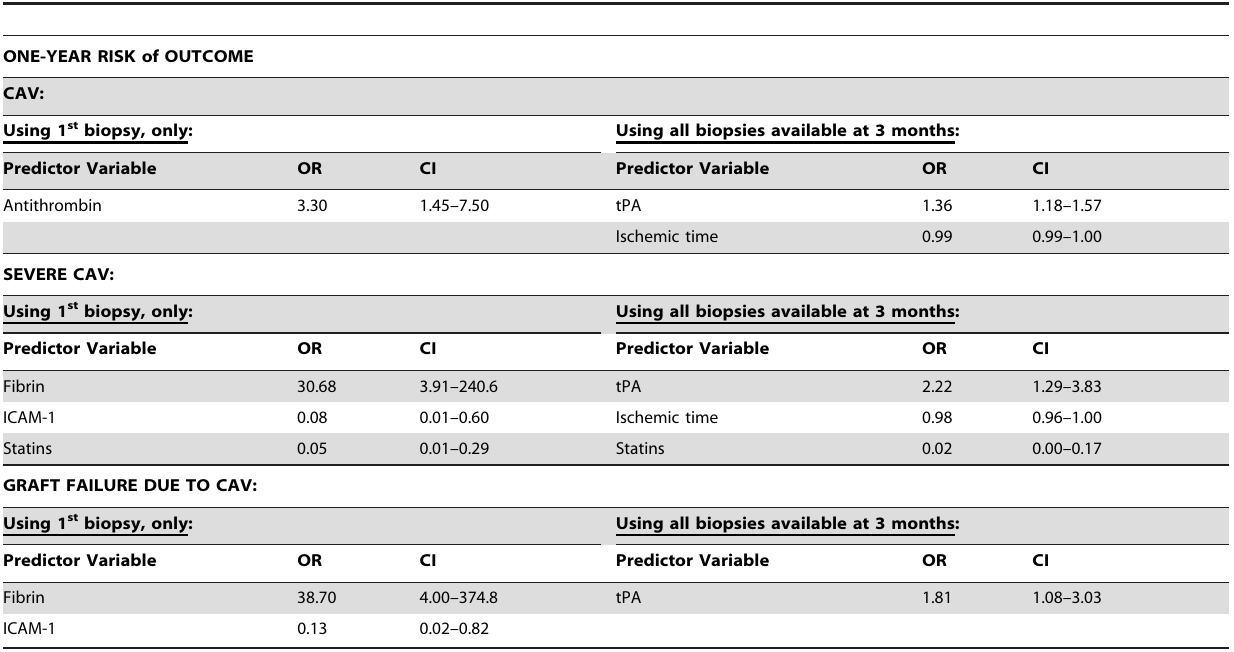
Table 3. Final multivariate logistic regression models using first-biopsy-only or three-month biopsy data to predict CAV, severe CAV, and graft failure due to CAV at one year